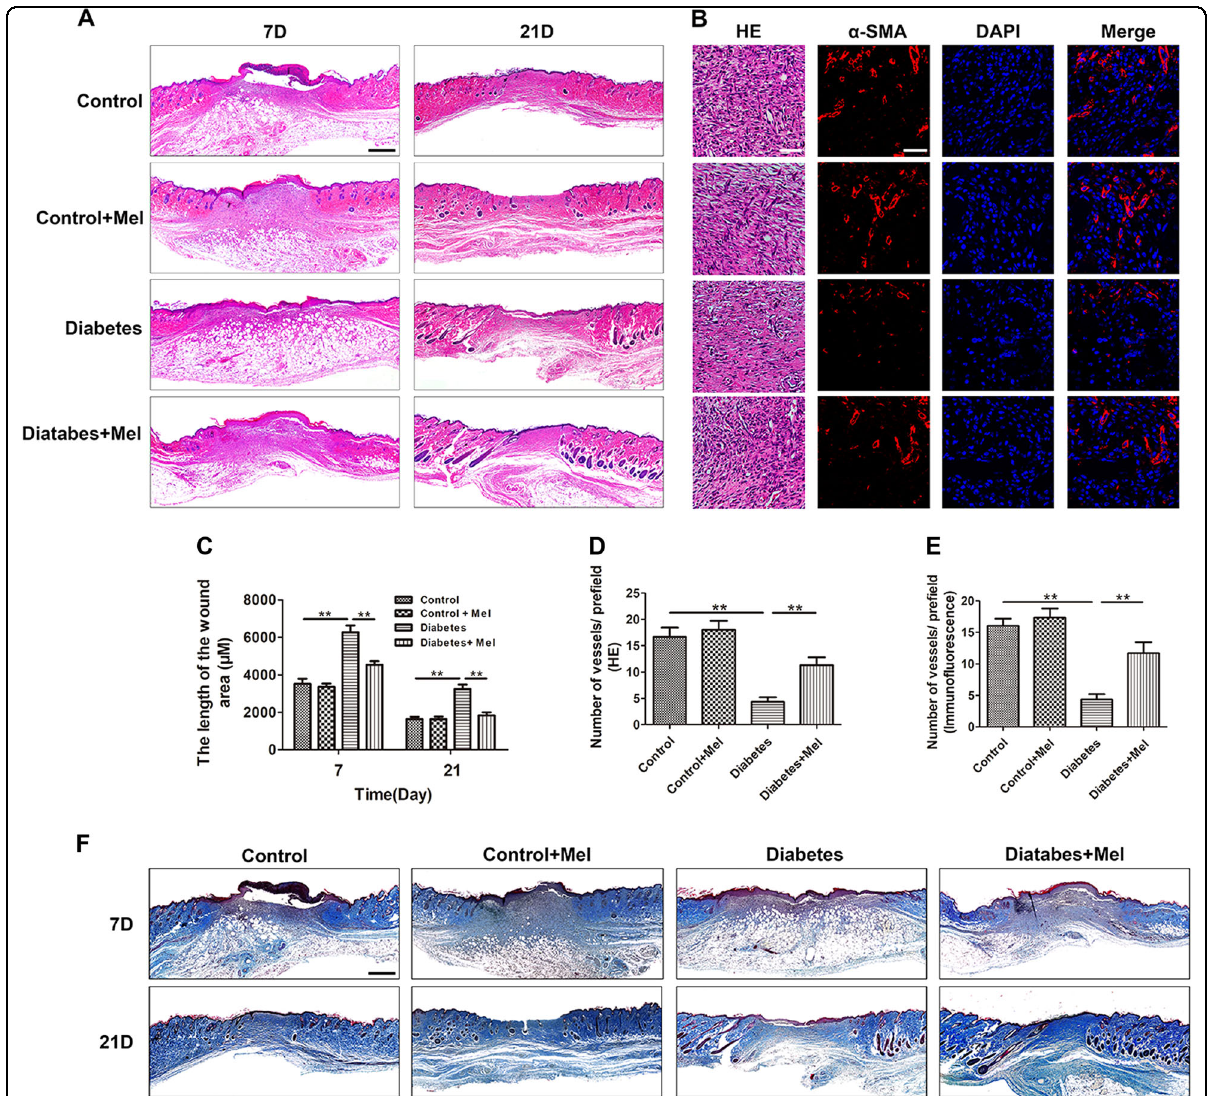
Fig. 7 Melatonin promotes wound healing. a Hematoxylin and eosin (H&E)-stained images of wound healing in different treatment groups on days 7 and 21. Scale bar, 1000 μ m. b , c New blood vessels were observed by α -SMA and H&E staining in enlarged images on day 7. Scale bar, 1000 μ m. d Wound lengths in different treatment groups on days 7 and 21. e , f Quantitative analysis of the number of vessels per fi eld on day 7 in H&E- stained and α -SMA-stained enlarged images. Scale bar, 100 μ m. g Masson ’ s trichrome staining of wound healing in different treatment groups on days 7 and 21. Scale bar, 1000 μ m. Data are presented as the mean ± SEM. Signi fi cant differences between the treatment and control groups are indicated as ** P <